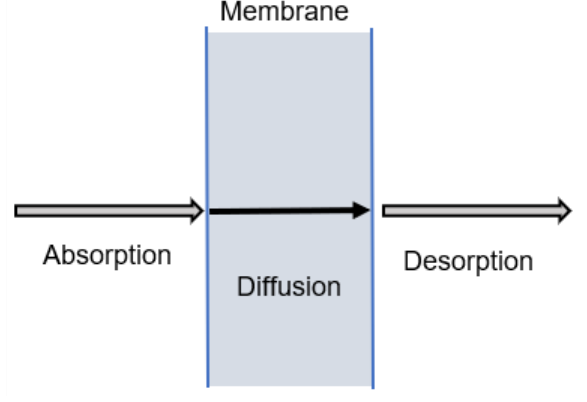
Figure 1. Solution diffusion scheme, source [40].